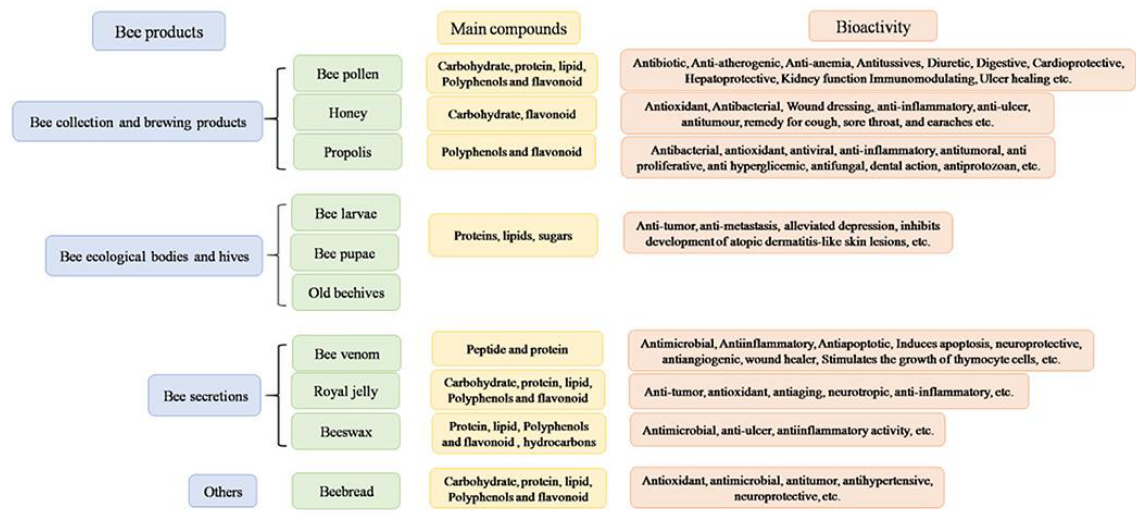
Figure 1. Bee-derived products — main components and bioactivity. Reprinted from [23].